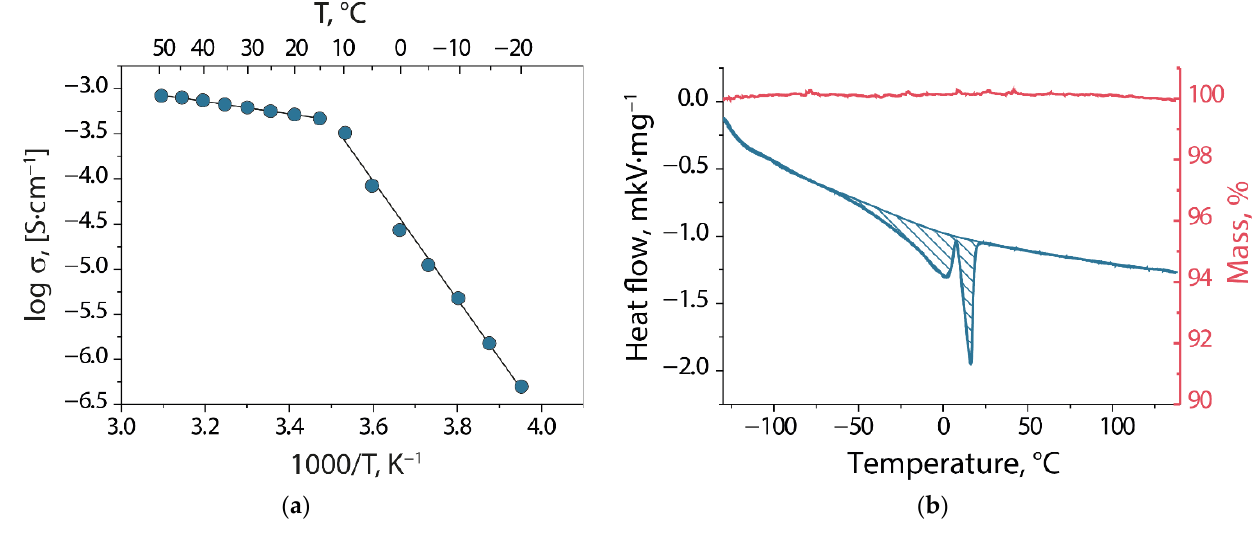
Figure 3. ( a ) Temperature dependence of ionic conductivity and ( b ) DSC (blue line) and mass loss curve (red line) of SSEBS-Ph when solvated by EC-DMA.